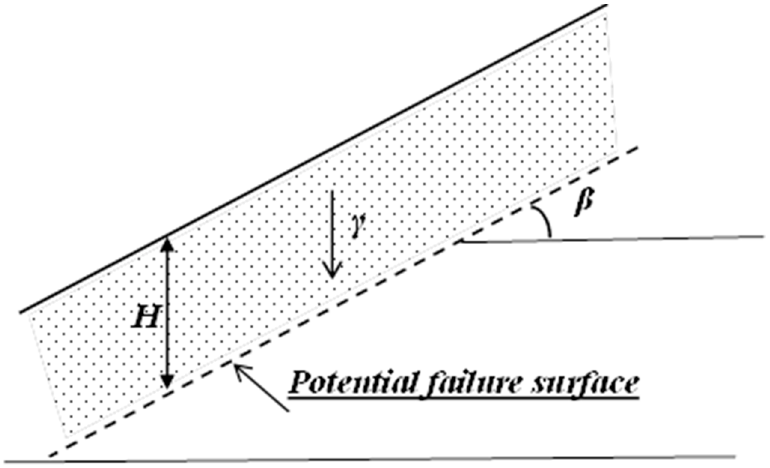
Figure 2. The infinite slope.